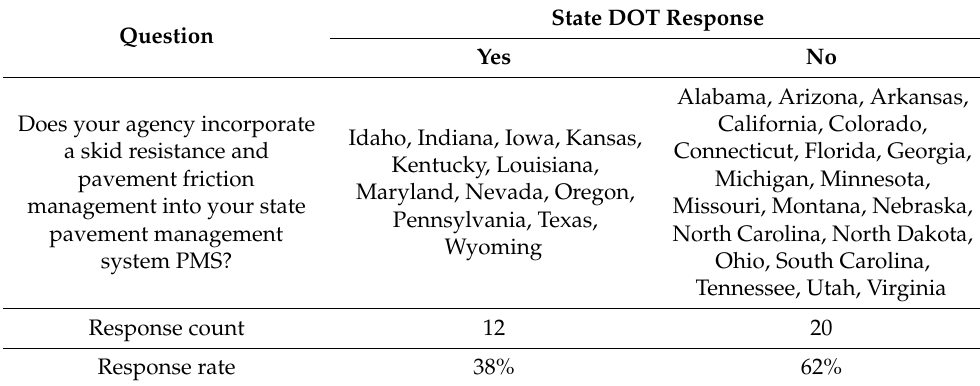
Table 3. State DOT feedback of the general policy of the pavement friction management.